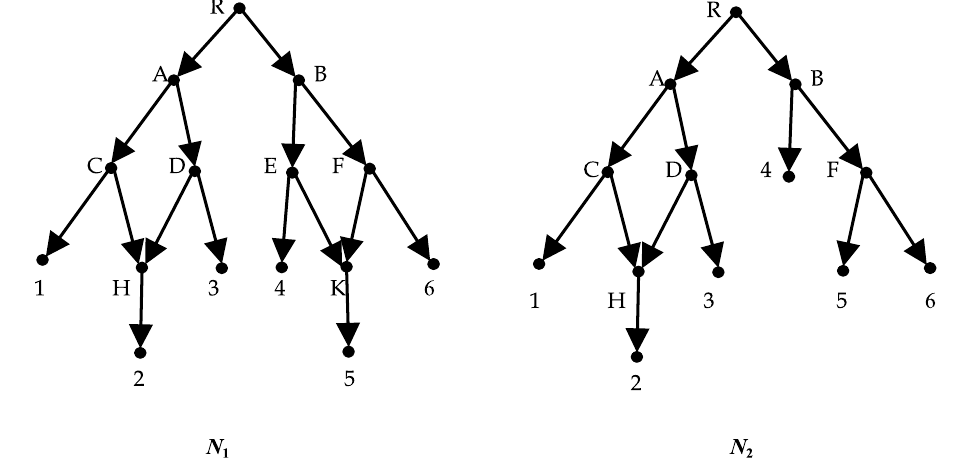
Figure 2. N 1 and N 2 on  = {1, 2, 3, 4, 5, 6} are not isomorphic.